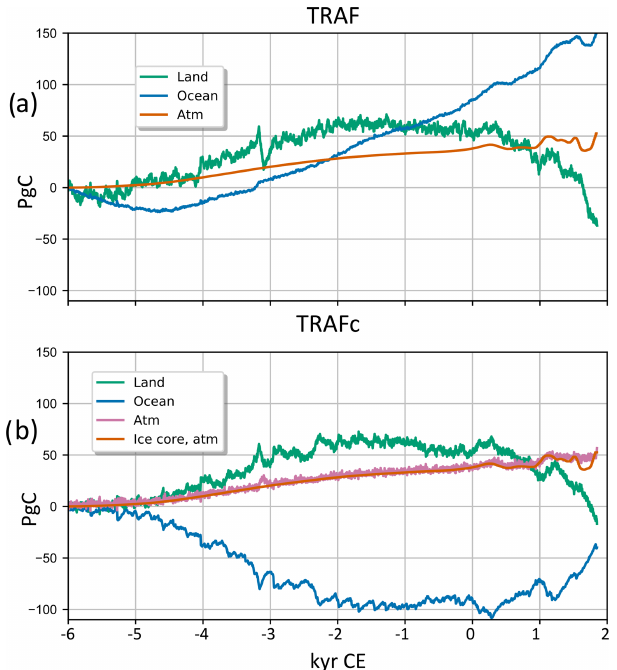
Figure 2. Changes in the cumulative fluxes for major carbon cycle components (land, ocean, and atmosphere) (PgC), from 6000BCE to 1850CE in the TRAF (a) and TRAFc (b) simulations. The colour legend is as follows: land is denoted in cyan, ocean in blue, atmo- sphere in magenta, and ice-core reconstruction in